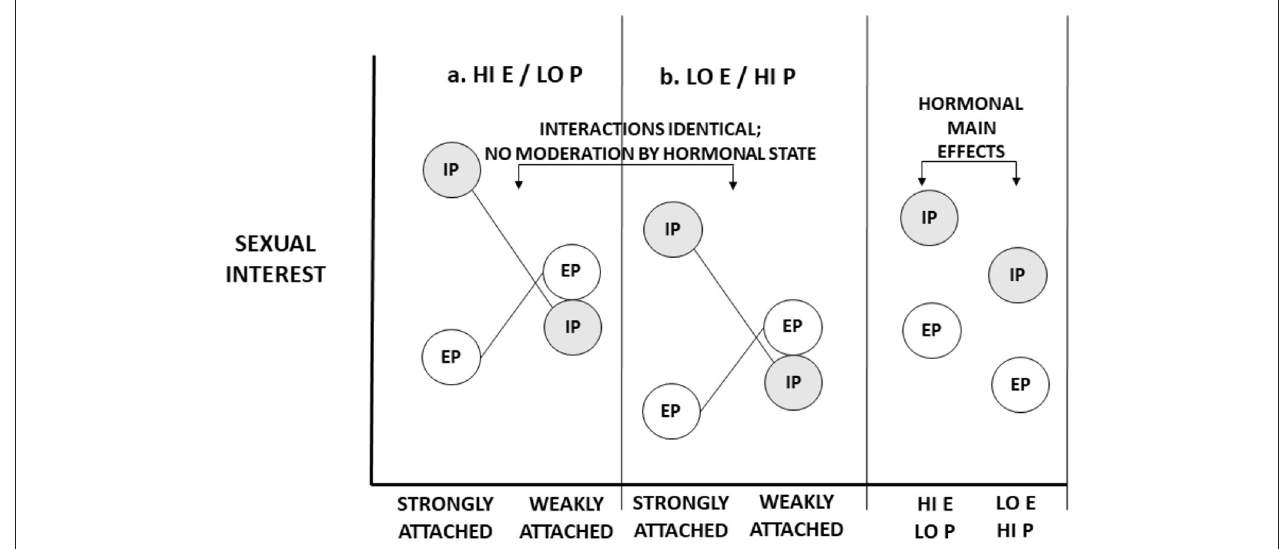
FIGURE 1 | Illustrative representation of the impact of ovarian hormones on “libido”—generalized sexual desire. Two hormonal states are represented: (a) High levels of estrogen (E) and/or low levels of progesterone (P), characteristic of the conceptive, peri-ovulatory phase; (b) (relatively) low levels of estrogen and high levels of progesterone, characteristic of the non-conceptive, luteal phase of the cycle. Two conditions are represented: Women in relationships in which they are strongly attached and bonded to romantic partners; and women in relationships in which they are weakly attached and bonded with partners. Sexual interests in partners (in-pair [IP] sexual interests) and men other than partners (extra-pair [EP]) sexual interests are considered. Hormonal states have main effects on sexual interests. Values in panel A “add” a constant value to sexual interest. This constant value is reflected in an overall main effect on both IP and EP sexual interests.